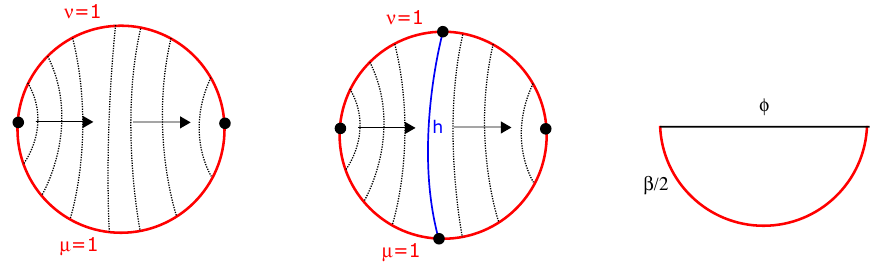
Figure 5 . BF evaluation of disk amplitudes. We use a Hamiltonian evaluation with the dashed lines being the fixed Euclidean time slices. Both endpoints of each time slice lie on the holographic bound- ary, where we impose the gravitational boundary conditions. Left: disk partition function. Middle: single boundary-anchored bilocal operator insertion on the disk. Right: Wheeler-DeWitt wavefunc- tion Ψ ( φ ) as a function of geodesic distance 2 φ , evolving from a half-circle with length β/ 2 β/ 2